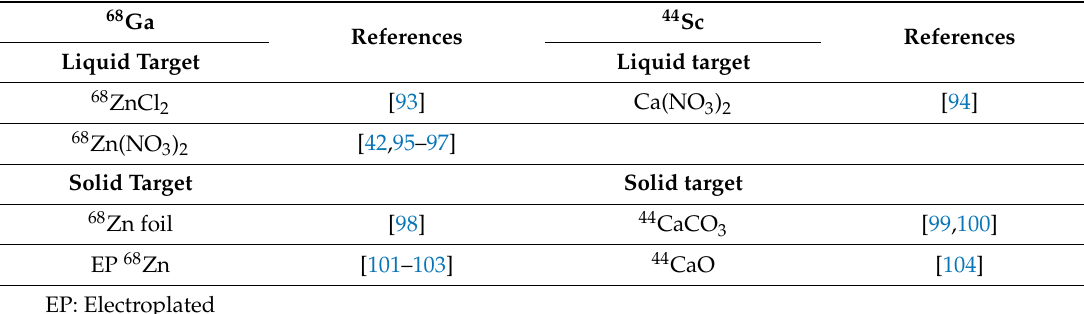
Table 3. Target material used for 44 Sc and 68 Ga production,